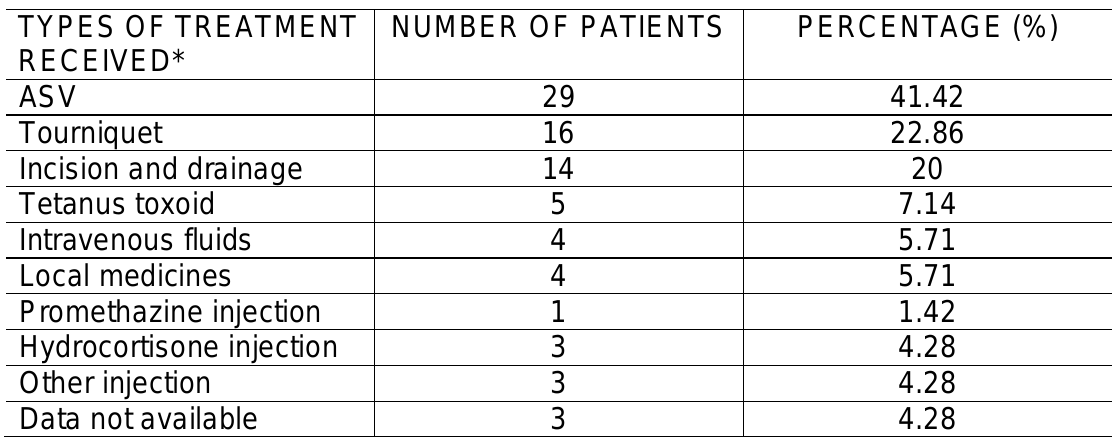
Table 2: Types of treatment given after